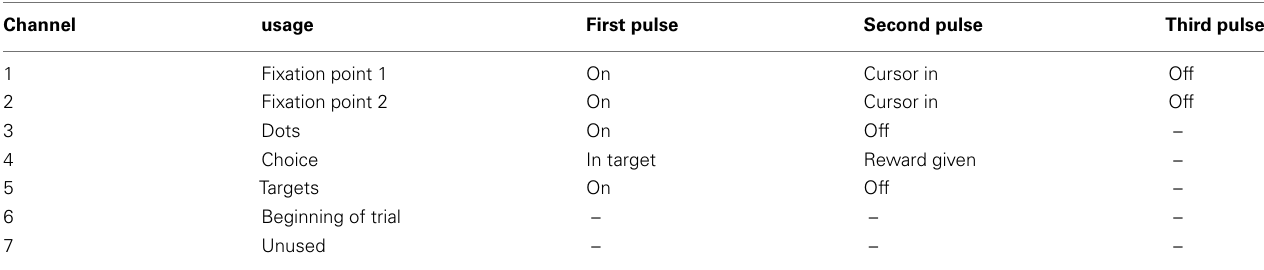
Table 1 | DIO channels for Datapixx to Plexon communication.